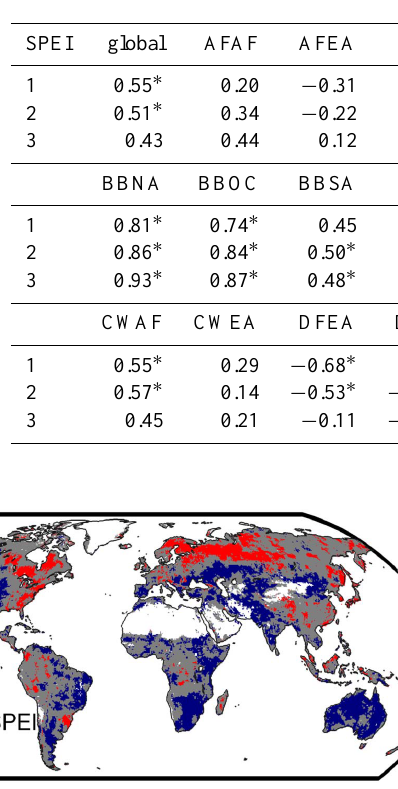
Table 2. Correlation coefficients ( R ) between annual anomalies of NPP and SPEI for the global and for the 24 regions explained in Table 1. Significant values ( p < 0 . 1) are indicated by ∗ .